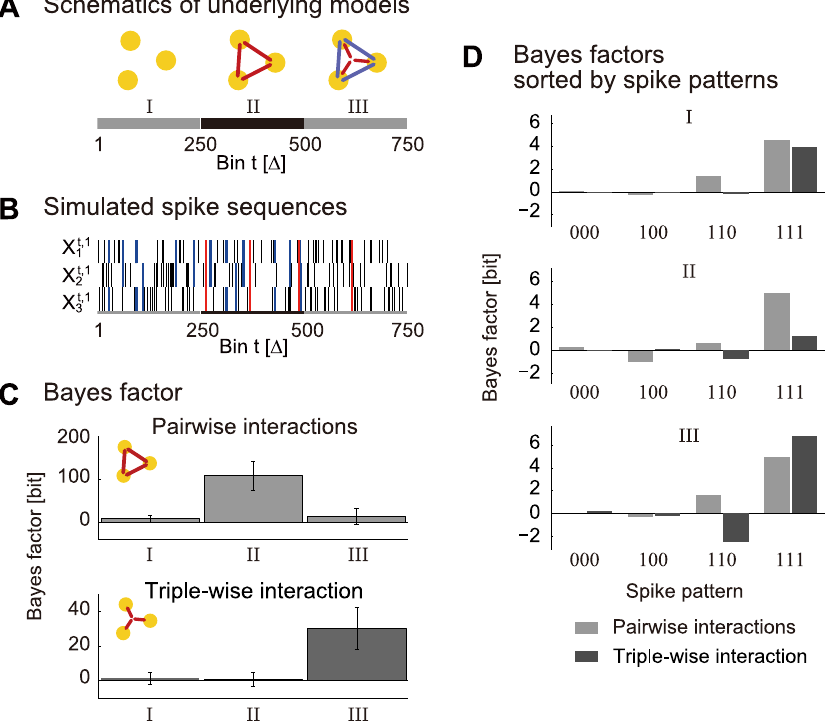
Figure 8. Analysis of stationary spike correlations of N ~ 3 simulated neurons using Bayes factor. (A) Sketch of different time periods and ~{ 2 : 2 , h t ~ 0 , h t ~ 0 for the underlying models used for the generation of parallel spike sequences: (I) Model of independent spiking ( h t i ij 123 ~{ 2 : 77 , h t ~ 1 : 57 , t ~ 1, ... ,250 and 1 ƒ i v j ƒ 3 ); (II) Model of simultaneously positive pairwise interactions, without a triple-wise interaction ( h t i ij ~ 0 for t ~ 251, ... ,500 ); (III) Model of triple-wise interaction, with negative pair interactions ( h t ~{ 2 : 09 , h t ~{ 2 : 69 , h t ~ 10 for t ~ 501, ... ,750 ). h t i ij 123 123 (B) Raster display of three parallel spike sequences, X t ,1 , within one example trial. Each spike is colored according to the spike pattern in which it appears: Spikes occurring in triplets are shown in red, spikes within doublets (all types) are marked in blue, and spikes not involved in any synchrony pattern are shown in black. (C) The bar plots demonstrate the Bayes factors (BFs), Eq. 48, for each of the time periods I–III in bit units. The upper panel shows the average BF when testing simultaneously positive pairwise interactions (Test 1), averaged across 200 realizations ( + 1 SD ). A positive value w 0 , while a negative value for the log of the BF supports the model for the presence of simultaneously positive pairwise interactions, M 1 : V I [ V 2 , h t I ƒ 0 . The BFs per sample and time period are computed by applying a pairwise state-space supports the absence of such an assembly, M 2 : A I [ V 2 , h t I log-linear model ( r ~ 2 ) independently to the three periods. We use a state model with F ~ I . The lower panel shows the BF for the positive triple-wise t w 0 , as opposed to a zero or negative triple-wise spike interaction, M ƒ 0 , in each of the three periods. The spike interaction (Test 2), M 1 : h t 2 : h 123 123 BFs are computed from a full state-space log-linear model ( r ~ 3 ). (D) Bar plot of the bin-by-bin BFs (Eq. 52) sorted by the different spike patterns in the three periods (from top to bottom). The contributions to the BFs (shown in C) from the different spike patterns are sorted and displayed using the indicated spike patterns (000, 100, 110 and 111) as representative examples. The gray bars indicate the average BFs of simultaneously positive pairwise interactions, with the average computed for the spike patterns observed in 200 realizations in the respective periods, while the dark gray bars indicate the average BFs for the triple-wise spike